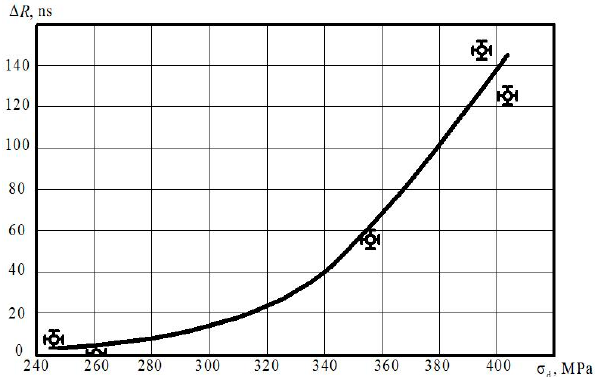
Figure 16. Influence of the amplitude of moment (long-range) fields of internal stresses ( σ d , MPa) on the delay time of the surface acoustic wave ( R , ns). The symbol means the field of values of the given quantity or the measurement